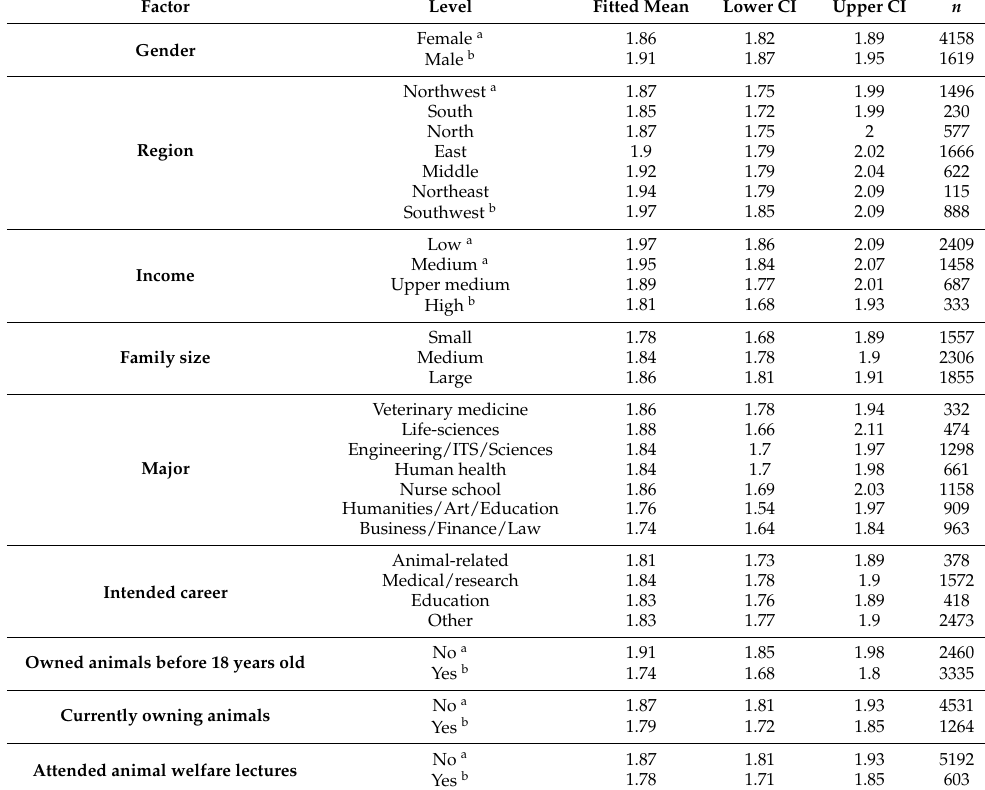
Table 3. Means and 95% confidence intervals (CIs) of scores towards animal Sentient model according to the students’ characteristics. Within each factor, categories that have different lower-case letters differ significantly (Wald chi-squared tests with Bonferroni correction). n = number of students. Factor Level Fitted Mean Lower CI n